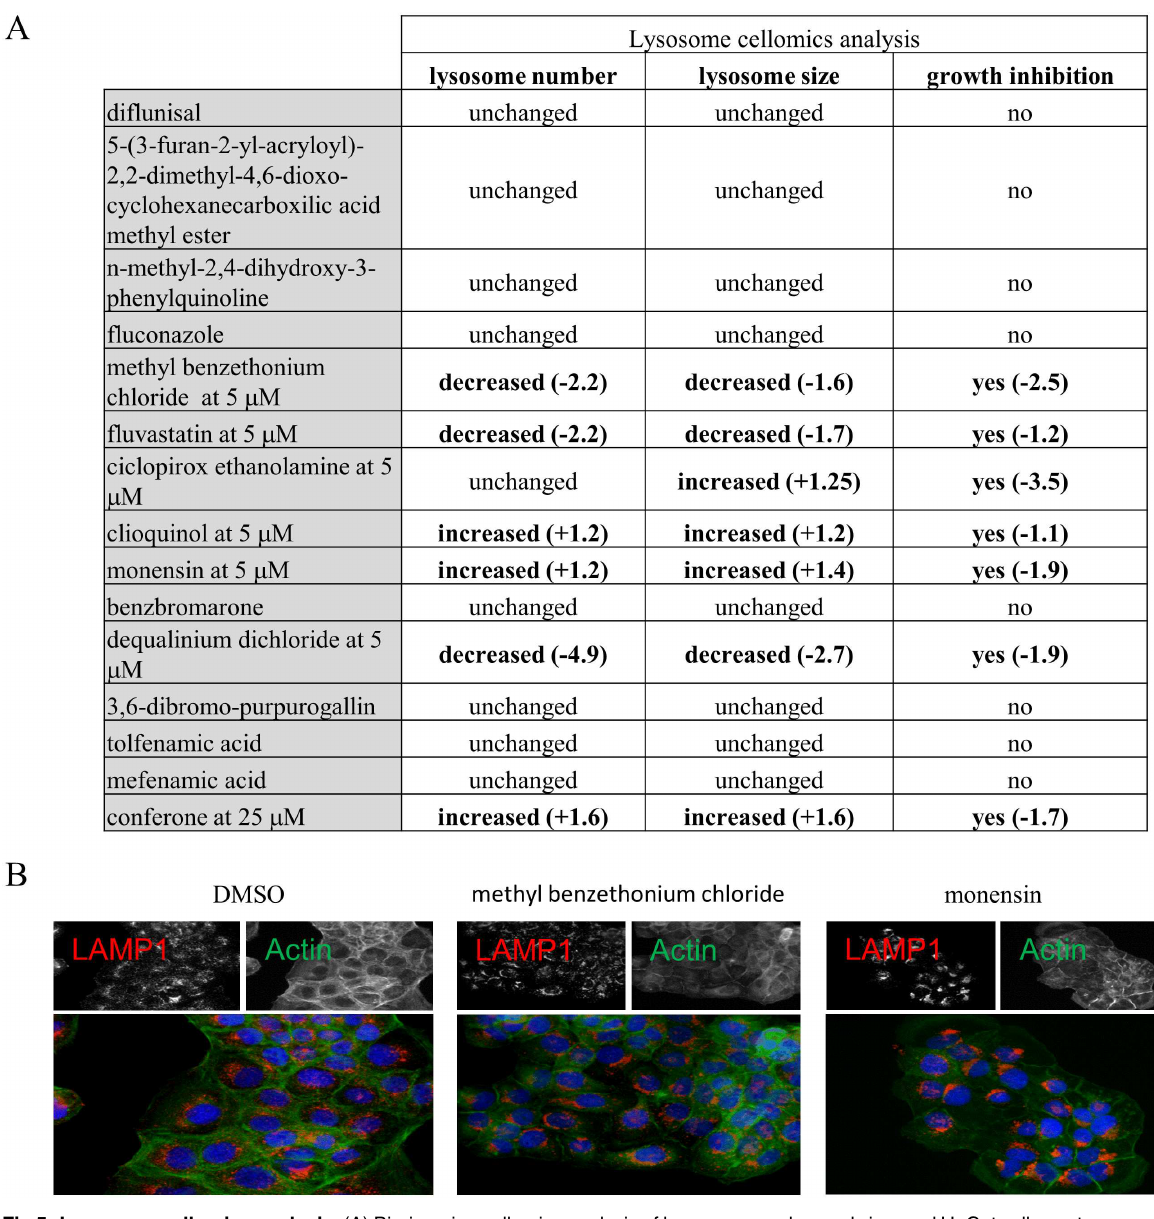
Fig 5. Lysosome cellomics analysis. (A) Bio-imaging cellomics analysisof lysosomenumber and size, and HaCat cell count. Numbers in brackets indicatethe fold variation relative to DMSO treated cells. Only significantdecreaseor increase are shown, and were obtainedfrom 6 replicates (p-value < 0.0001). Compounds were tested at 5, 25 and 50 μ M. The minimalconcentration causingabnormal lysosomenumber and/or size is indicatedfor each of the active compounds. Fluconazole was used as a control, and the order of the compoundsrelates to the order in Fig 3. (B) Immunofluorescence was performed using DAPI to detect the cell nucleusand anti-LAMP1 antibodyto detect lysosomes. Methyl benzethoniumchloridewas tested at 5 μ M and monensinat 50 μ M.